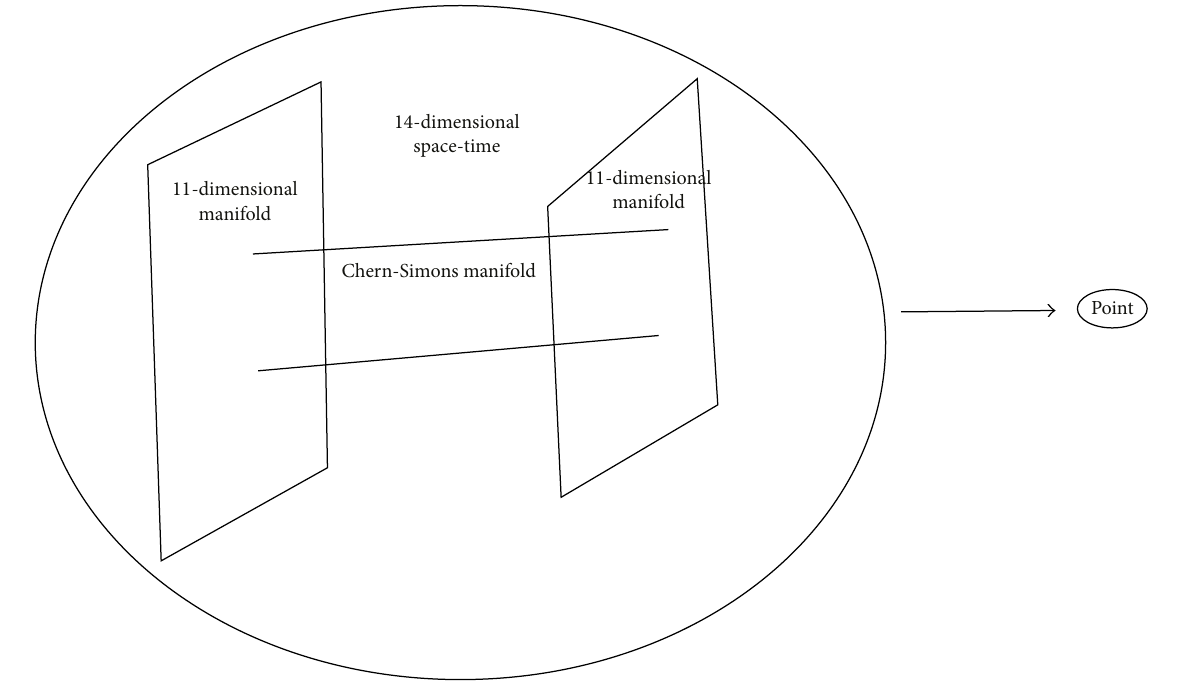
Figure 2: 14-dimensional manifold shrinks to one